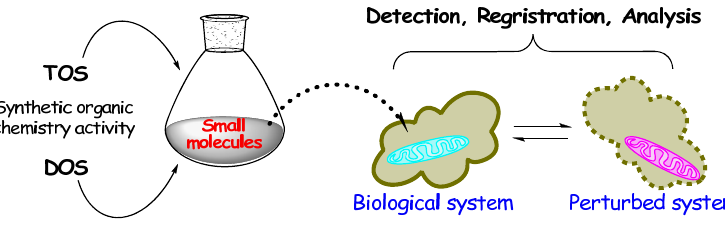
Figure 6. A simplified scheme of chemical biology